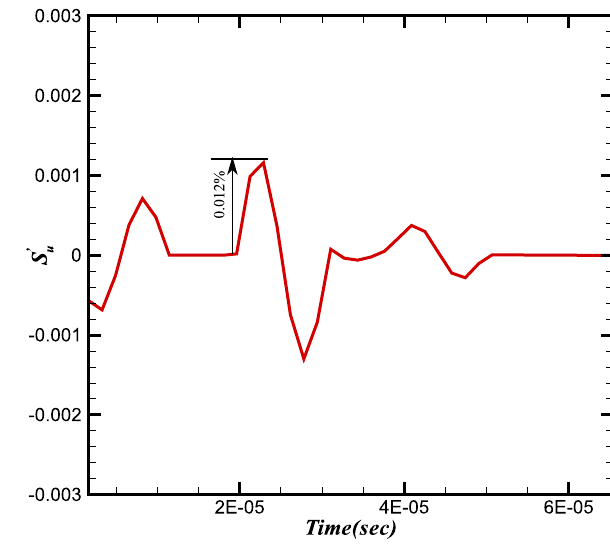
Figure 6. Relative change in reaction rate of CH 4 .